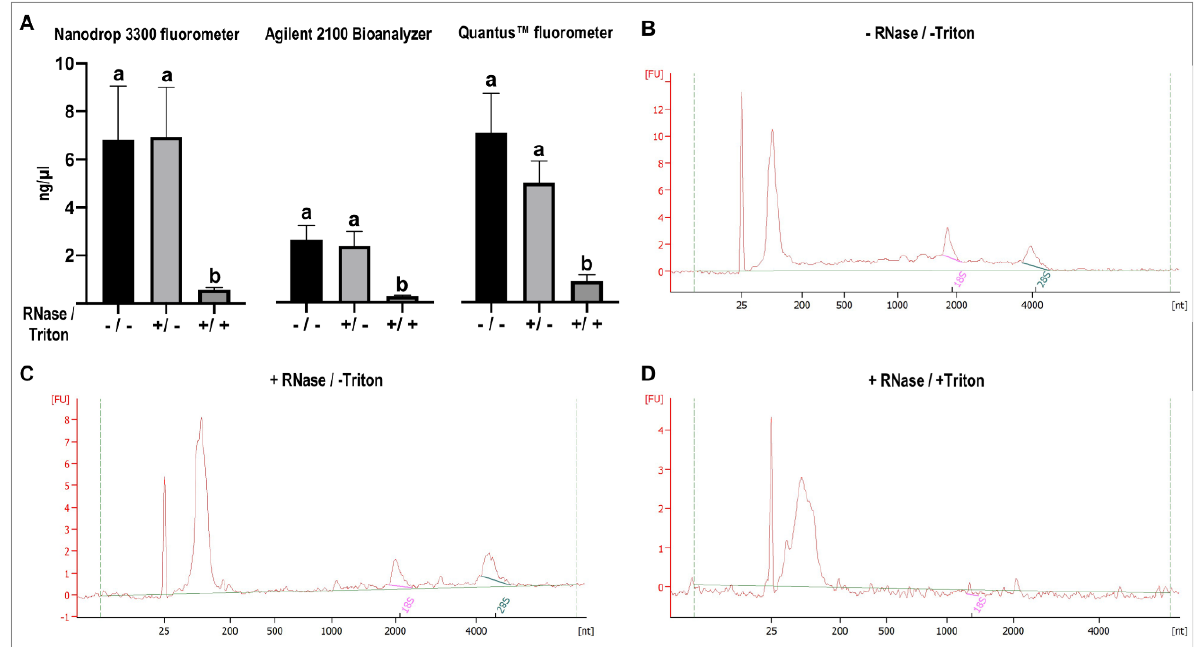
Figure 9. RNA quality and quantity of equine uterine extracellular vesicles (EVs) after RNase protective assay. EVs samples were treated with RNase (+/−), RNase and Triton X-100 (+/+) or not treated (−/−). ( A ) RNA was isolated and measured with Nanodrop 3300 fluorometer, Agilent 2100 Bioanalyzer, and Quantus™ fluorometer. Different letters indicate significant differences among RNA treatments (a,b: p < 0.05). Bioanalyzer profiles show RNA quality assessment of not treated EVs samples ( B ); EVs samples treated with RNase but not Triton X-100 ( C ); and EVs samples treated with RNase and Triton X-100 before RNA isolation and quantification ( D ).